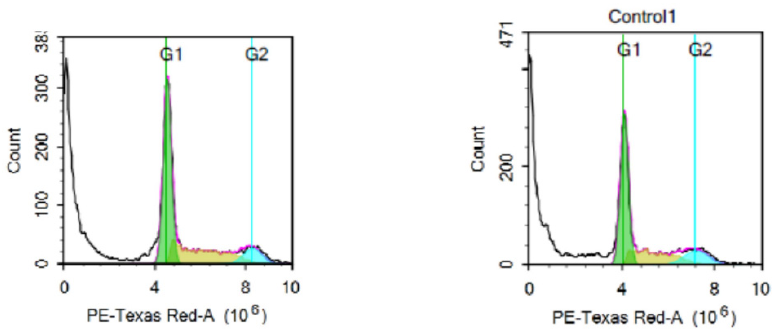
Figure 3. Cell cycle analysis of 12e on T-47D cell line (G1 (growth phase 1) in green, S phase (synthesis phase) in yellow, and G2 (growth phase 2) in light blue).